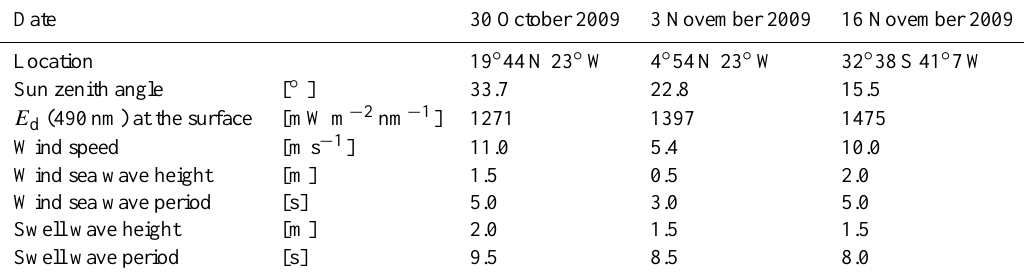
Table 1. Environmental conditions at three measuring sites onboard the R/V Polarstern (cruise ANT-XXVI/1) with same inherent optical properties of the upper ocean mixed layer.